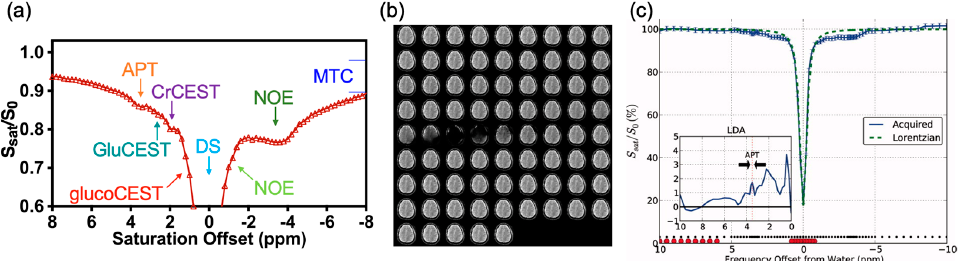
Figure 1. ( a ) Schematic illustration of the Z-spectrum with multiple CEST contrast. APT: amide proton transfer; GluCEST: glutamate CEST; CrCEST: creatine CEST; glucoCEST: glucose CEST; DS: direct water saturation; NOE: nuclear Overhauser effect; MTC: magnetization transfer contrast. ( b ) Saturated images as a function of saturation frequency for a human brain slice. ( c ) In vivo Z-spectra and Lorentzian difference analysis (LDA) for a region in the white matter of the human brain. Figure panels ( b , c ) are reproduced with permission from Jones et al. Magn Reson Med 2012;67(6):1579–1589. Copyright John Wiley and Sons, 2012.